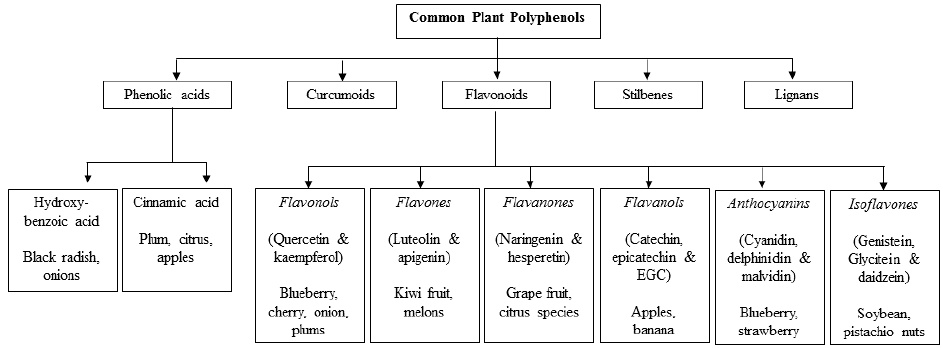
Figure 1. Classification of polyphenols, examples and dietary sources [11–17]. EGC—epigallocatechin.